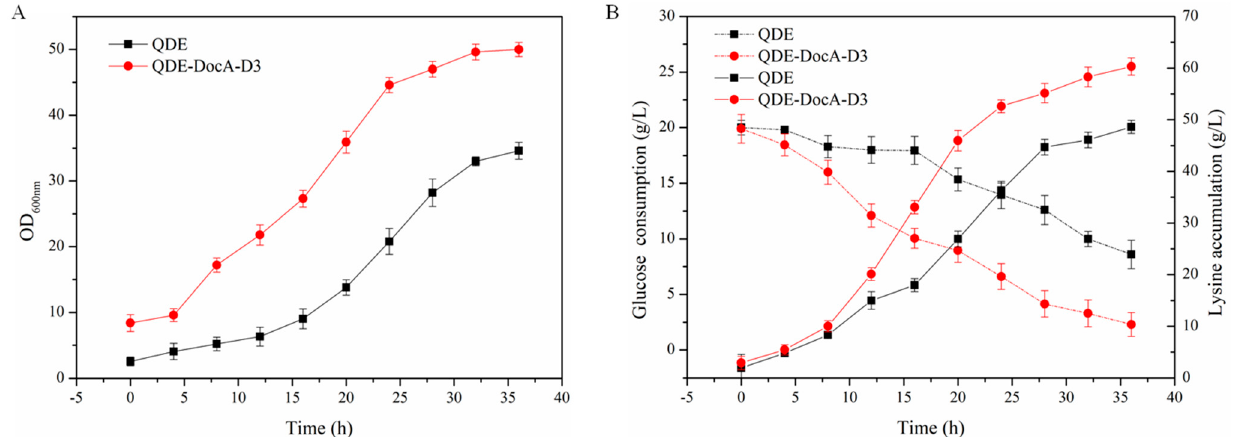
Figure 6. Assembly efficiency of cellulosome elements combined with key enzymes in L-lysine fermentation. ( A ) The changes in OD 600 during fermentation and growth of bacterial cells. ( B ) The changes in carbon source consumption and L-lysine accumulation during bacterial growth and fermentation.